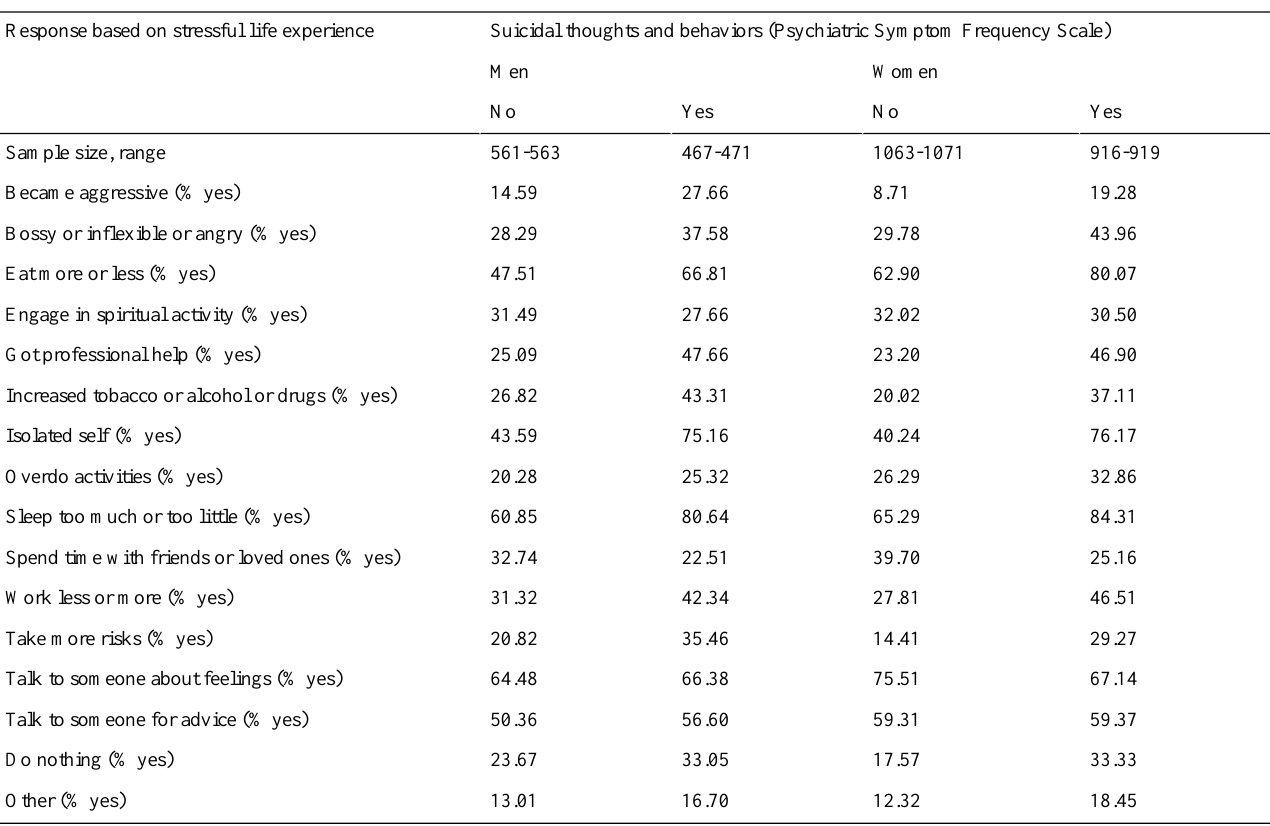
Table 4. Frequency of men’s and women’s coping responses after experiencing a stressful transitional life event for participants who did and did not report suicidal thoughts and